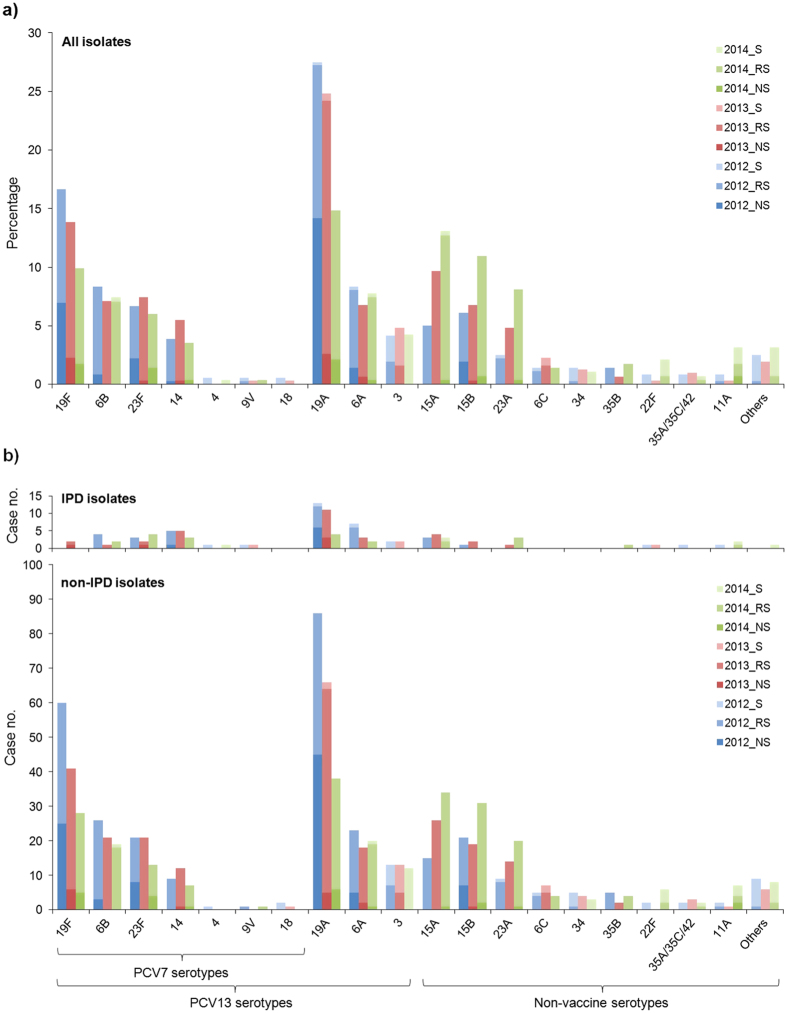
Penicillin susceptibility among (a) all isolates and (b) invasive pneumococcal disease (IPD)-related isolates (upper) and non-IPD isolates (lower). Panel (a) is expressed in accumulated percentages using the respective annual total isolate number as the denominator. (S, susceptible, ≤0.06 mg/L; RS, reduced susceptible, 0.06-2 mg/L; NS, non-susceptible, >2 mg/L) (Other serotypes are as those listed in Fig. 2).